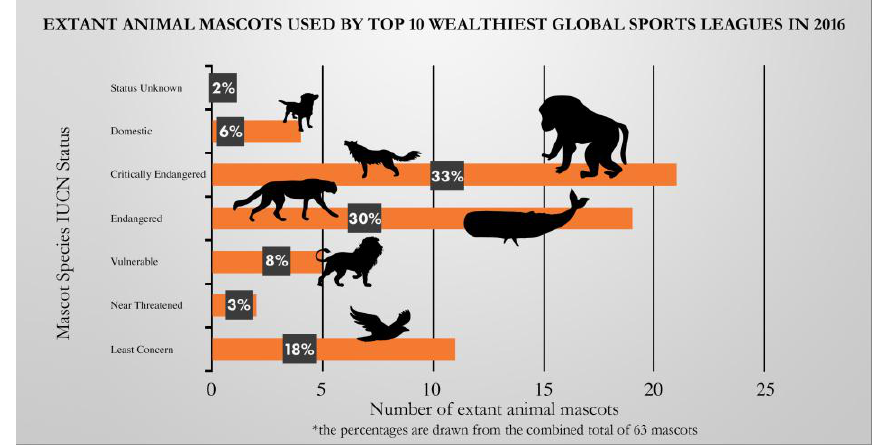
(cid:48) s top 10 wealthiest sports